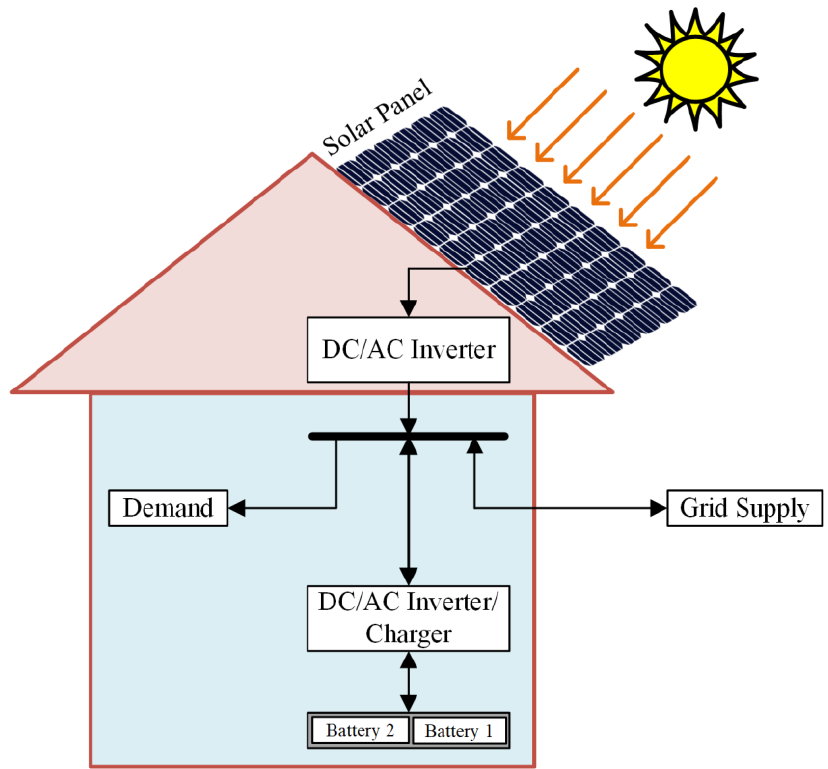
Figure 3. Schematic of the photovoltaic and battery storage systems (BESS).